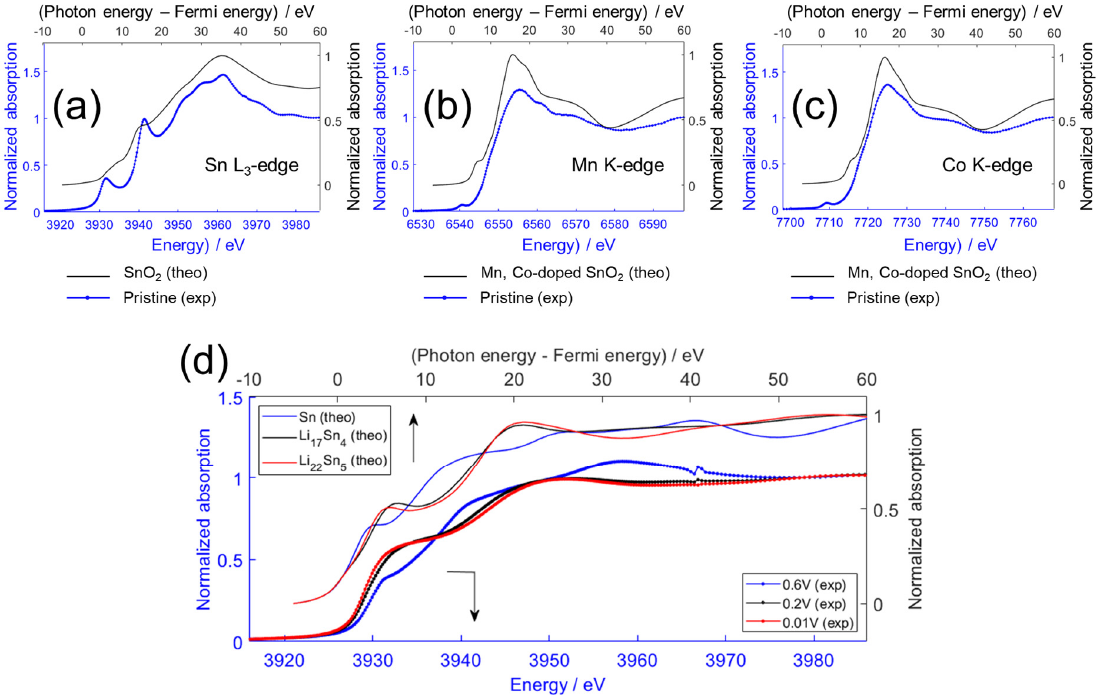
Figure 8. Comparison of the experimental and simulated XANES spectra: ( a ) Sn L 3 − edge of the pristine sample; ( b ) Mn K − edge of the pristine sample; ( c ) Co K − edge of the pristine sample; ( d ) Sn L 3 − edge of the ex situ samples discharged to 0.6 V, 0.2 V, and 0.01 V.